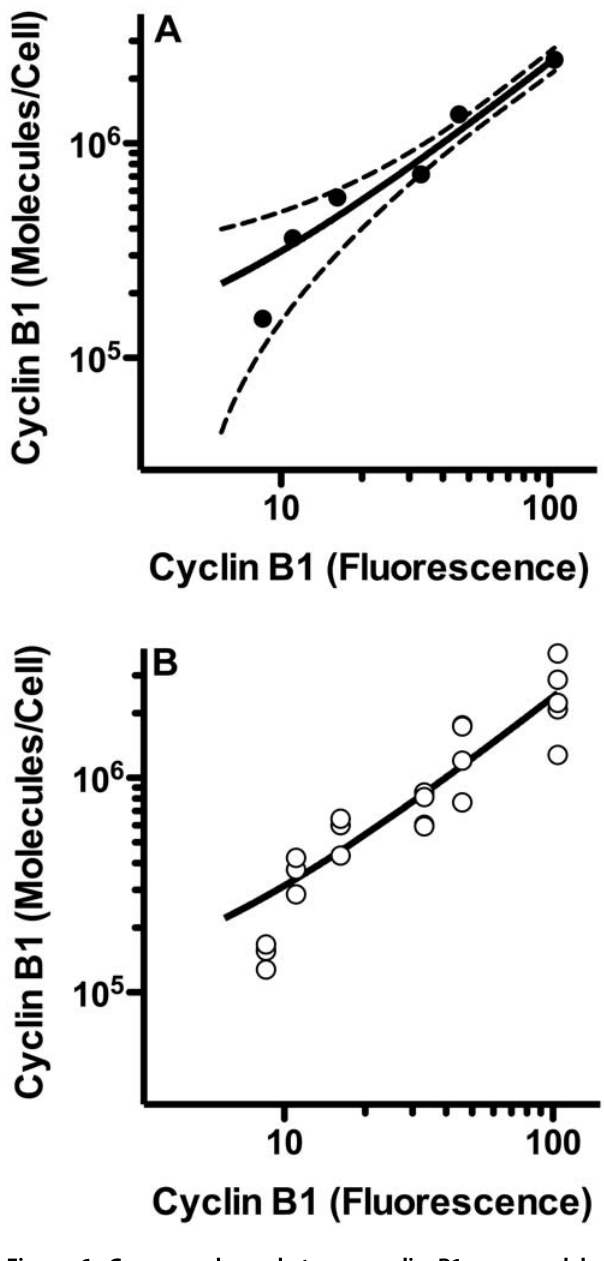
Figure 6. Correspondence between cyclin B1 measured by cytometry and by Western blotting. Average cyclin B1 levels were calculated from luminescence measurements of imaged Western blots then plotted versus mean fluorescence values (representative data shown in Figure 5). ( A ) Means and the 95% confidence interval are plotted. Cytometry was performed in duplicate. Western blots varied from 3 to 6 replicates. Individual values are plotted in ( B ). the standard curve (white circles). A plot of molecules per cell determined by cytometry and by Western blots is shown in Figure 7D. Determination of molecules by cytometry and the standard curve agreed with Western blotting for K562 (cytome- try = 1.2 X Western). However, for RKO, the cytometry/standard curve method produced a mean that was 2.2 X that of the Western blots. For HeLa cells, cytometry = 0.4 X Western. These differences are acceptable when compared to other efforts to